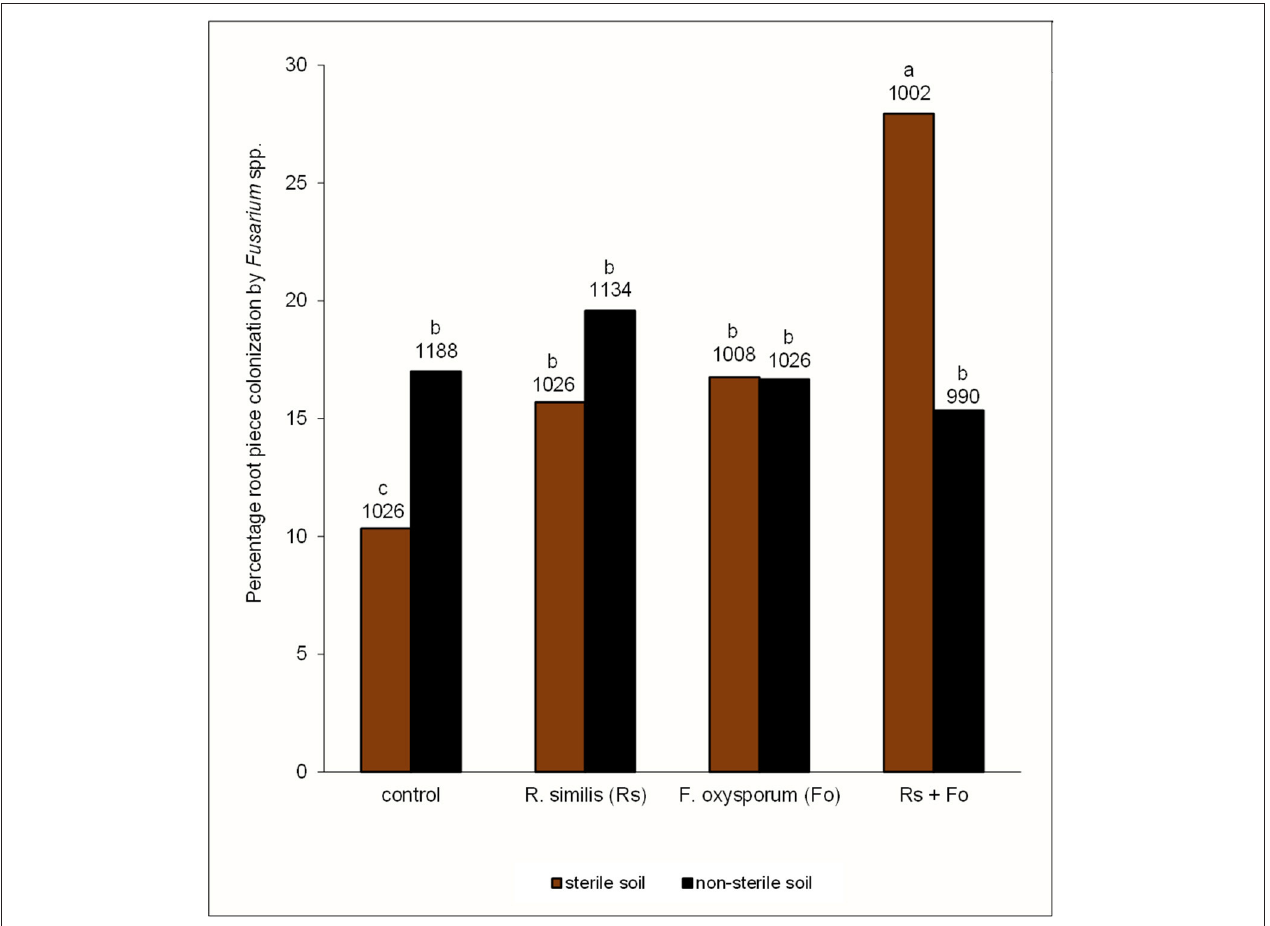
FIGURE 7 | Percentage root piece colonization by Fusarium spp. in potted tissue culture banana plants under independent or combined inoculation with Fusarium oxysporum V5w2 and Radopholus similis , grown in either sterile soil or non-sterile soil supplied with complete nutrient solution. Bars with the same letter represent values that are not statistically different ( p > 0.05), with the sample sizes indicated below the letters (df